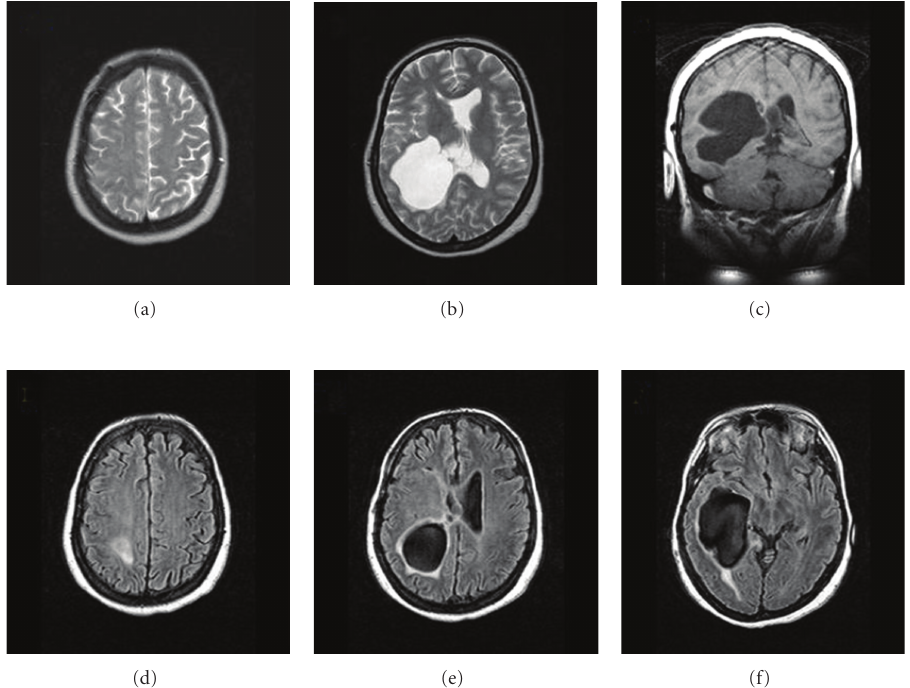
Figure 4: Magnetic resonance imaging (2006): (a) and (b) T2 weighted axial images; (c) T1 weighted coronal image; (d), (e), and (f) axial FLAIR (Fluid Attenuated Inversion Recovery) images. There are obstructive hydrocephalus and ventricular deformities, suggestive of intraventricular cystic lesions.